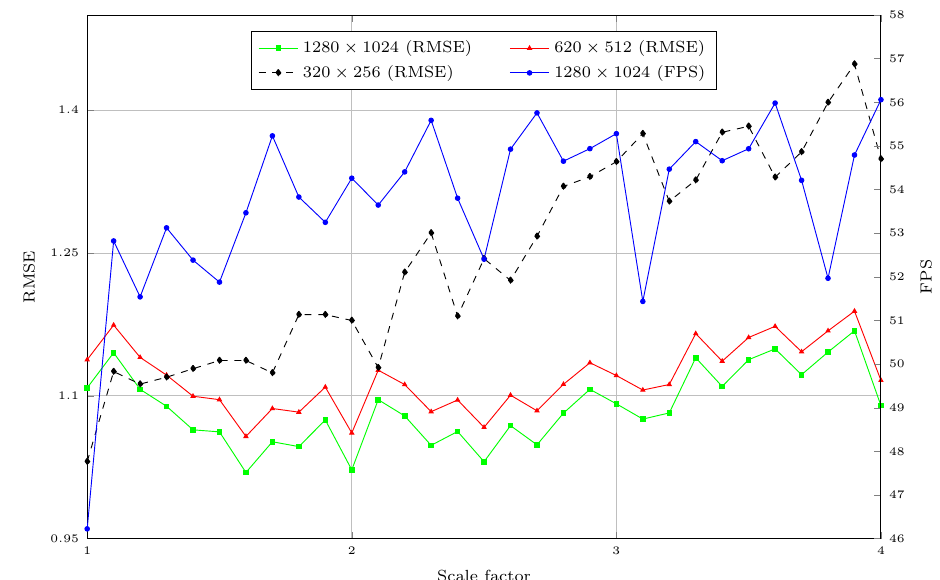
Figure 15. The RMSE and FPS of different upsampling factors [ 1.0,1.1,1.2,1.3,...,3.7,3.8,3.9,4.0 ] of the proposed method on the Matterport3D